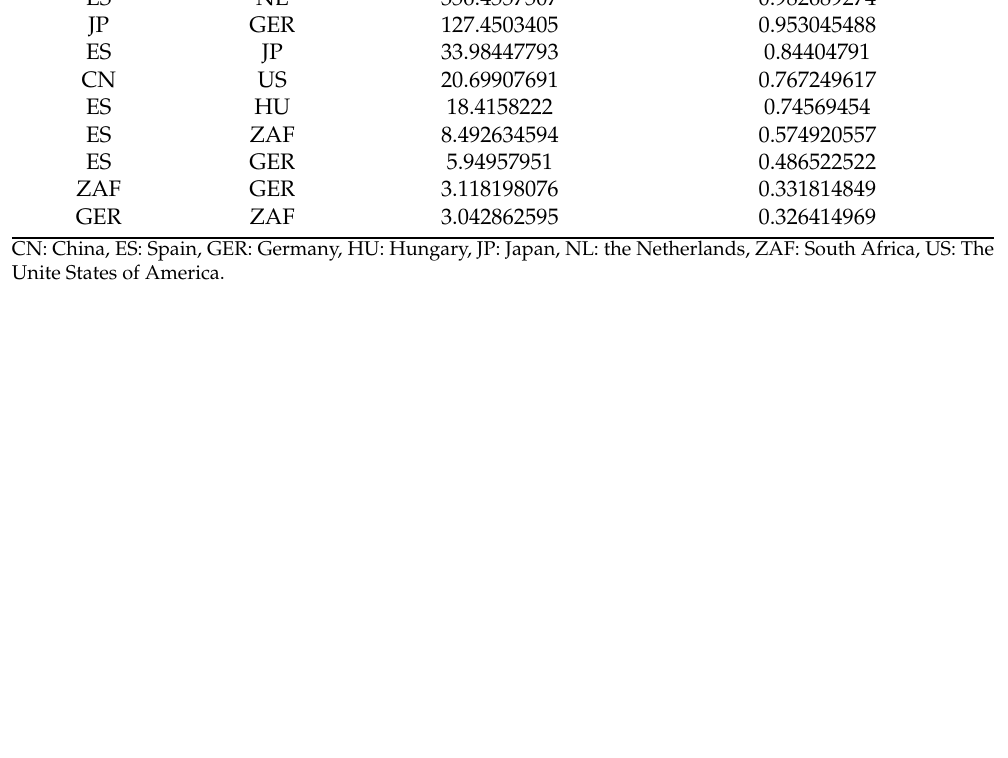
Figure 5. The transmission route of PKV across the world. BI tree of the complete coding region after removal of recombination region is reconstructed using BEAST under the skygrid model. Table 1. Bayes Factor (BF) and Posterior Probability (PP) tests for PKV transmission links across the world. From To Bayes Factory (BF > 3) Posterior Probability (PP > 0.3)